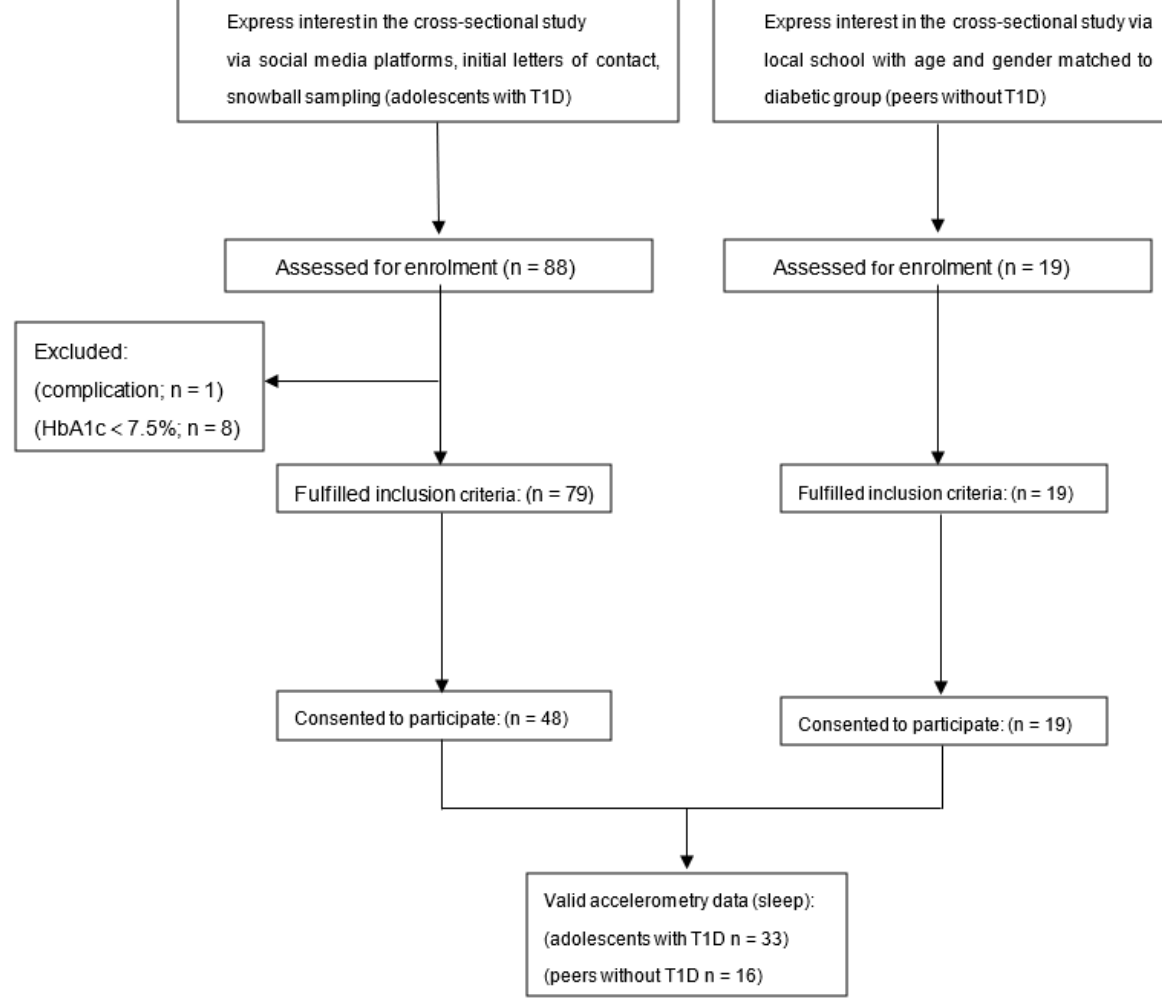
Figure 1. Flowchart of participant